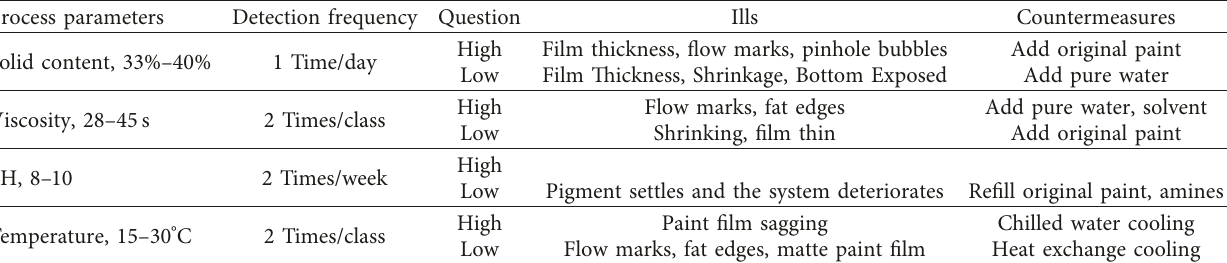
Table 2: Control of dipping bath liquid, parameter changes, and their influence on the paint film.